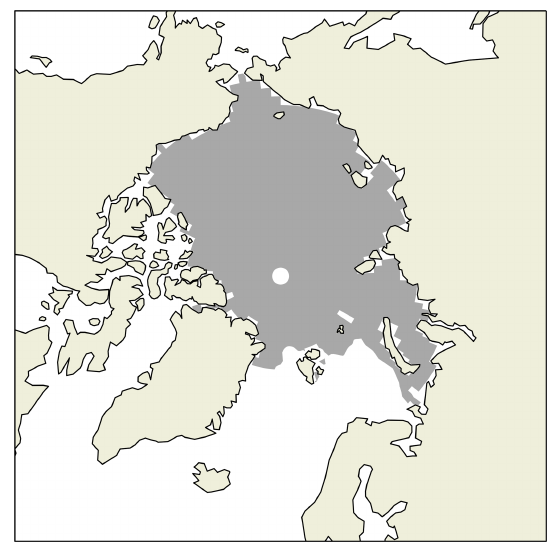
Figure 1. The Arctic Ocean region used in the analysis, defined as the area enclosed by the Fram Strait, Bering Strait and the northern boundary of the Barents